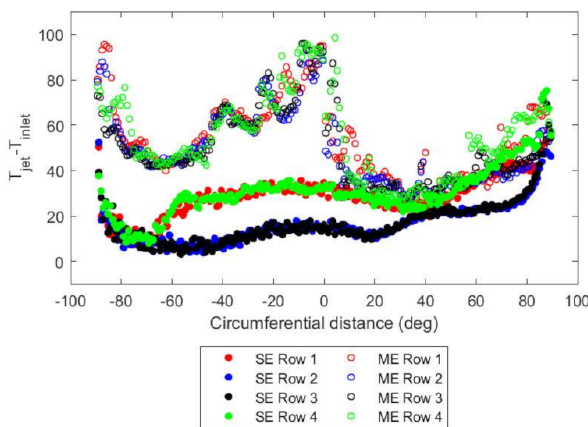
Figure 16. Circumferential distribution of increase in static temperature across all four arrays of holes for both single–entry and multiple–entry cases at 50% mass flow rate condition.